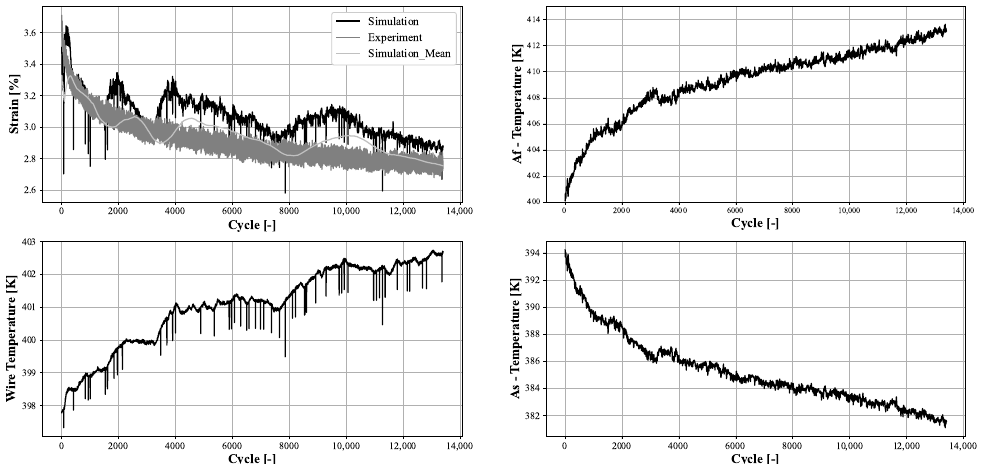
Figure 11. Example of a simulated strain compared to the experiment. The simulation was based on the input parameters for energy and electric resistance shown in Figure 10. Overall, the simulated stroke fits the measured values. A deeper statistical analysis of the predicted parameters is performed in Section 6. The assumption of a decreasing tendency in the stroke is met. At approximately cycle 1800, 3800 and 8000 the stroke starts to rise again. The reason for that lies in the accuracy of the measuring equipment. A further look into the electric resistance in Figure 10 shows the mean value of the electric resistance and the energy. Both variables behave accordingly: At the investigated cycles the resistance and the energy both show a “bump” that explains the deviation in the calculated